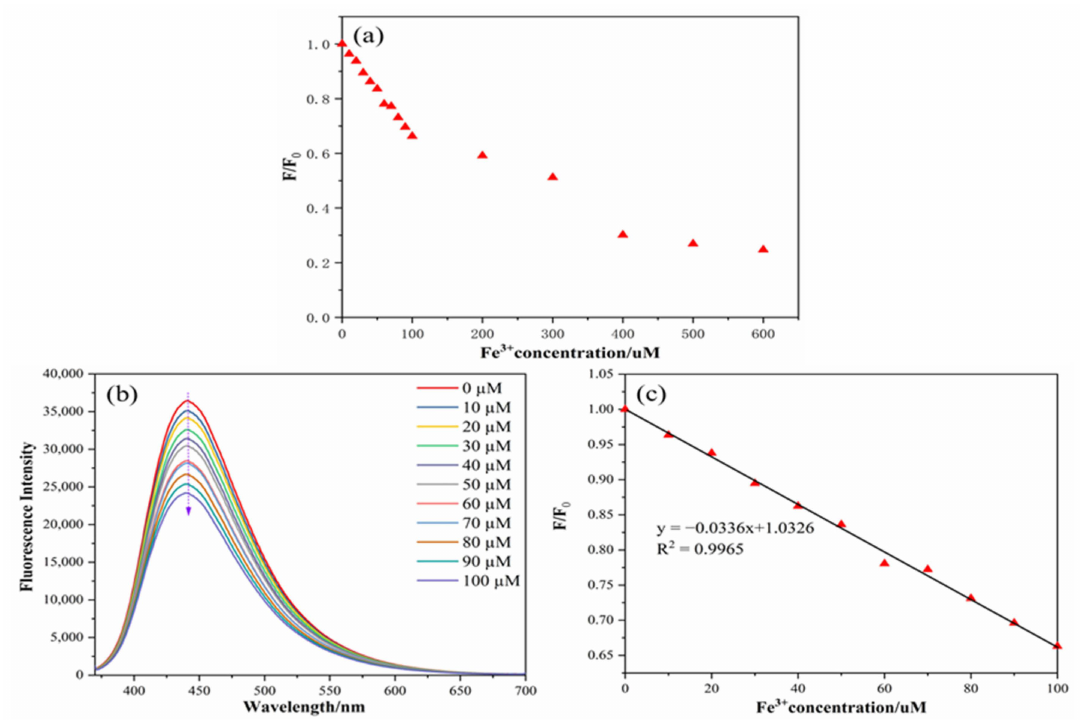
Figure 7. Relative fluorescence intensity changes in N,S-CDs under different concentrations of Fe 3+ ( a ), fluorescence intensity spectra of N,S-CDs under different concentrations of Fe 3+ ( b ), and linear relationship between Fe 3+ concentration and fluorescence intensity of the N,S-CDs ( c ).